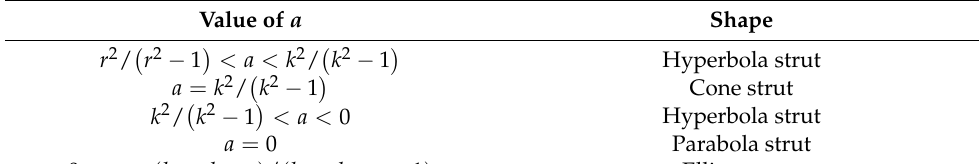
Table 1. Strut type defined by a.